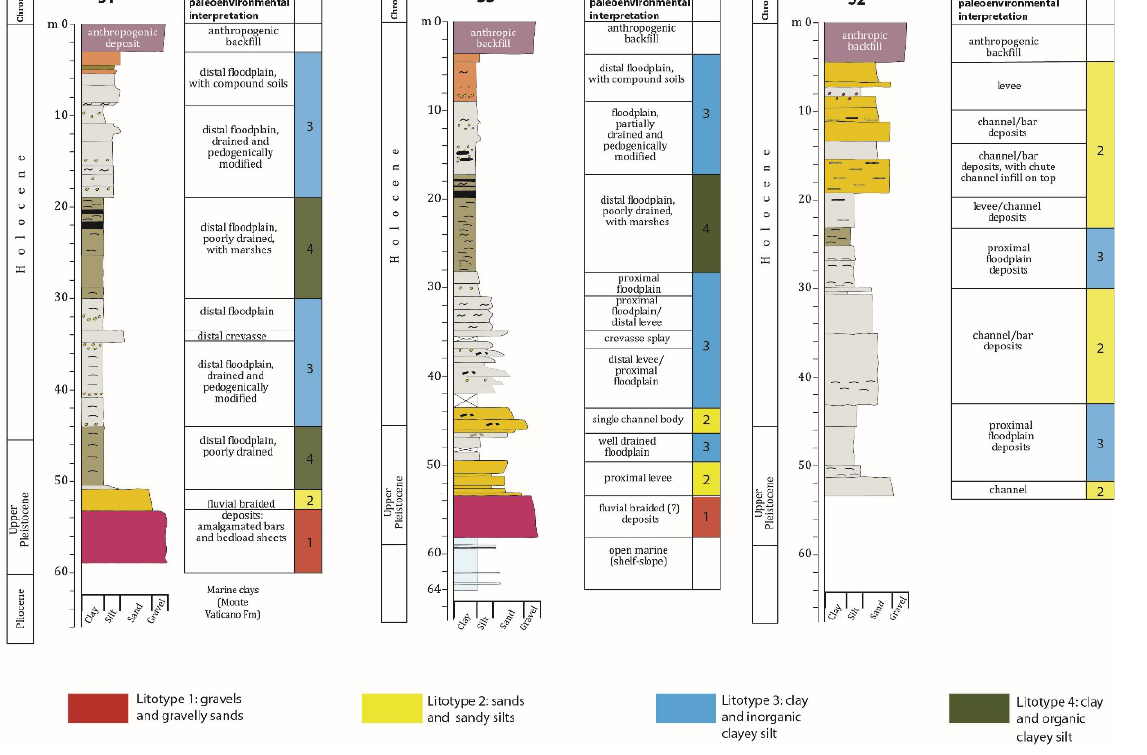
Figure 8. Stratigraphic-sedimentologic logs of boreholes S1, S2, and S3 (after